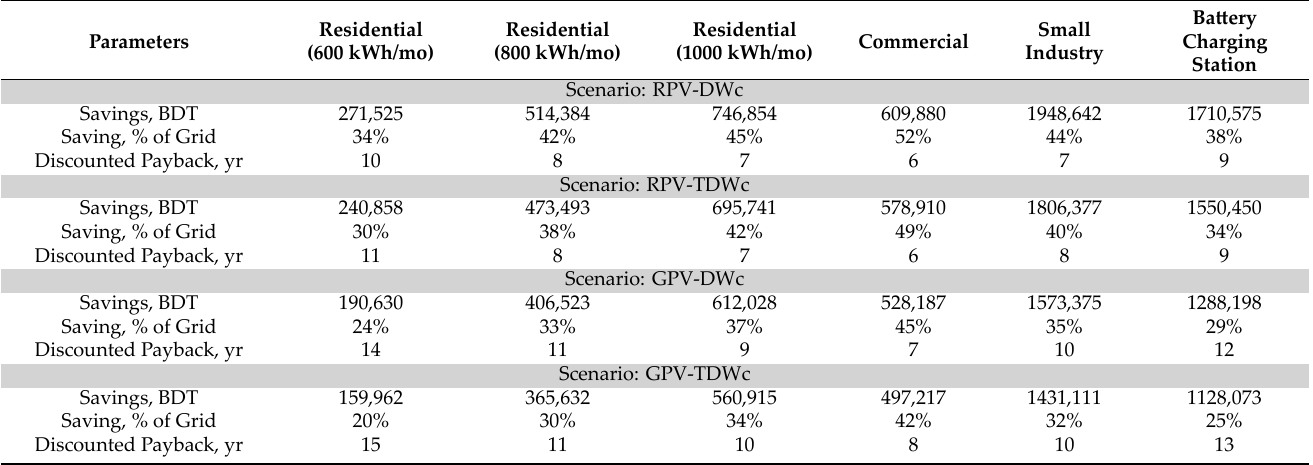
Table 9. Saving and discounted payback period overview for all